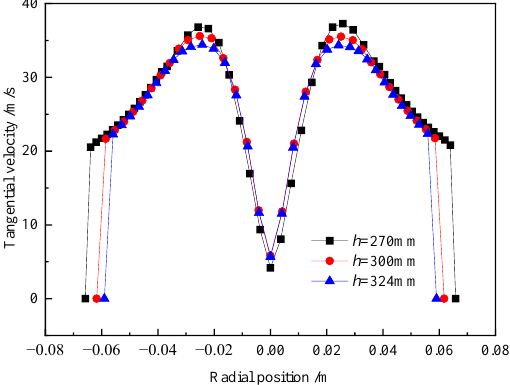
Figure 14. The tangential velocity for different cone length in z = −5 00 mm.